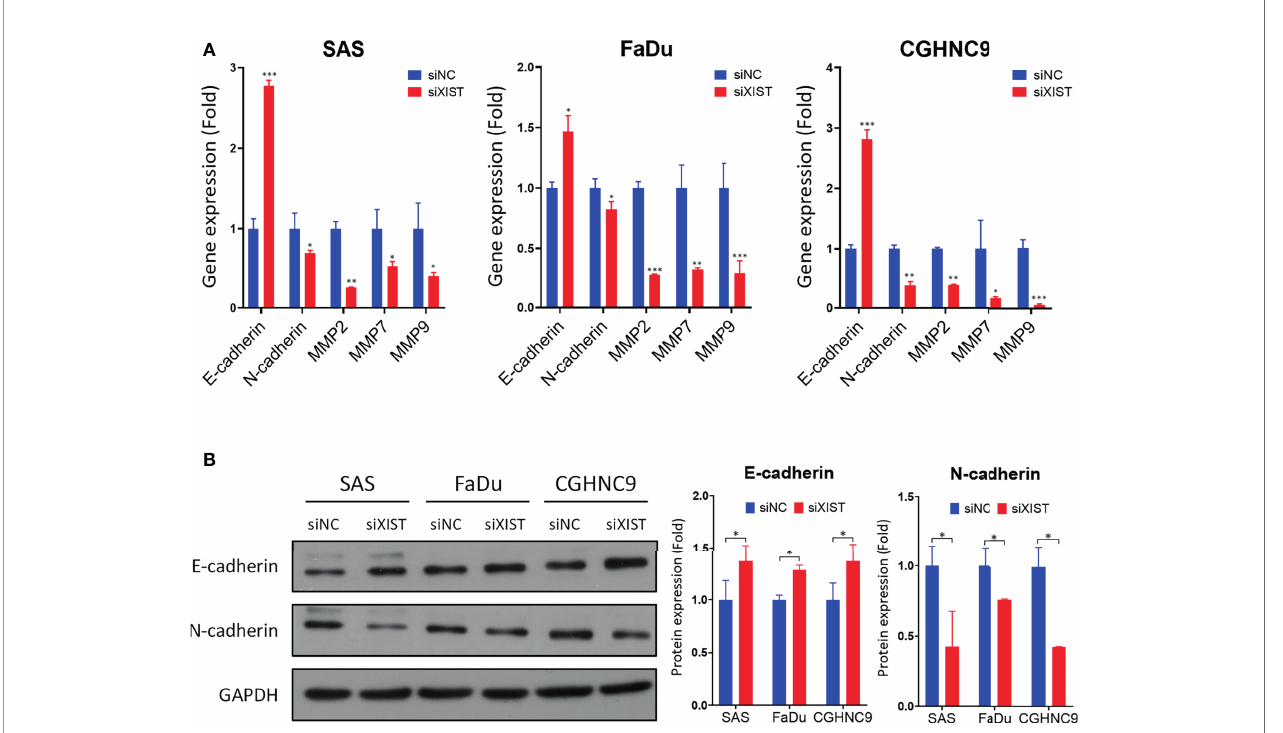
FIGURE 8 | Downstream molecular analysis of XIST-mediated migration and invasion dysregulation. (A) RT-qPCR of EMT-associated genes were performed in SAS, FaDu, and CGHNC9 cell lines post-XIST silencing. MMP and mesenchymal markers were downregulated, while the epithelial marker E-cadherin was upregulated. (B) Protein expression of EMT markers were analyzed through western blotting. Quanti fi cation was achieved using imageJ software. (***p ≤ 0.001, **p ≤ 0.01, *p ≤ 0.05,